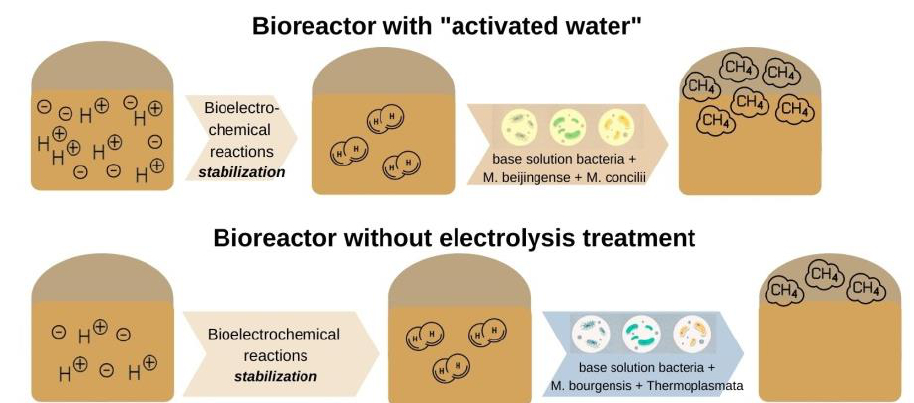
Figure 3. Bioelectrochemical reactions in the system with ‘activated water’ and the experiment without electrolysis treatment during the initial period.